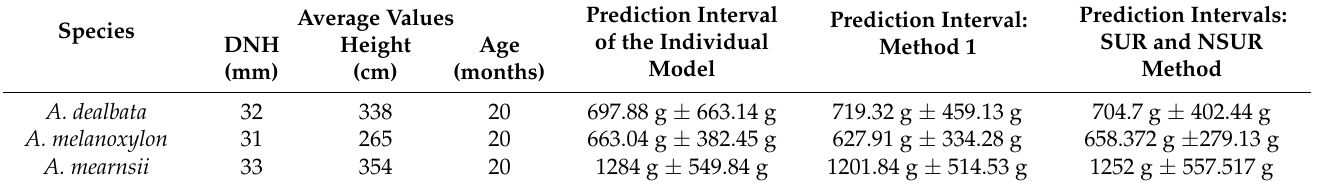
Table 4. Prediction intervals of 95% to estimate the total biomass based on the average values of the predictor variables. Average Values Prediction Interval Species